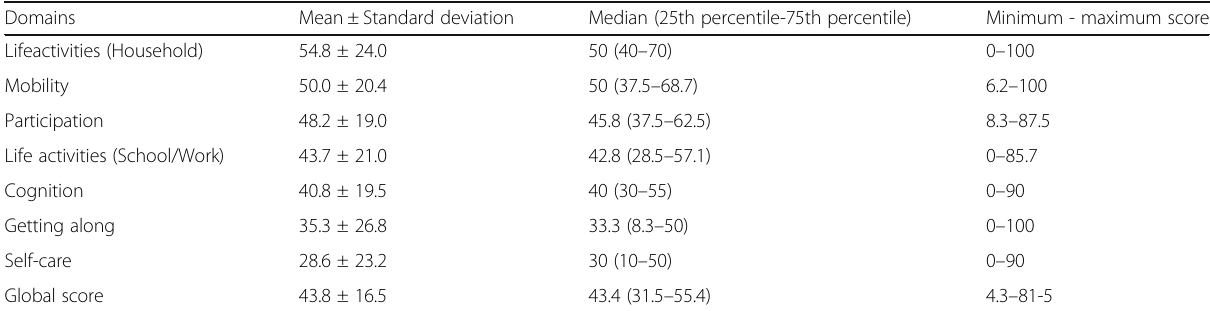
Table 2 Mean and median score for each domain and the global score of WHODAS 2.0